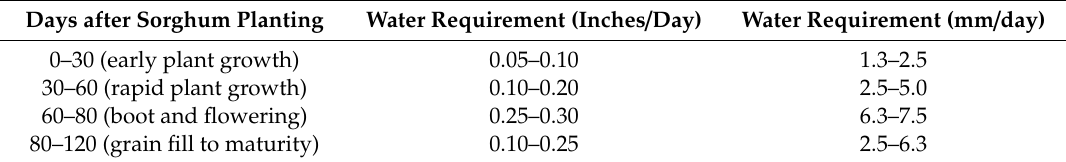
Table 1. Estimated grain sorghum water use by growth stage